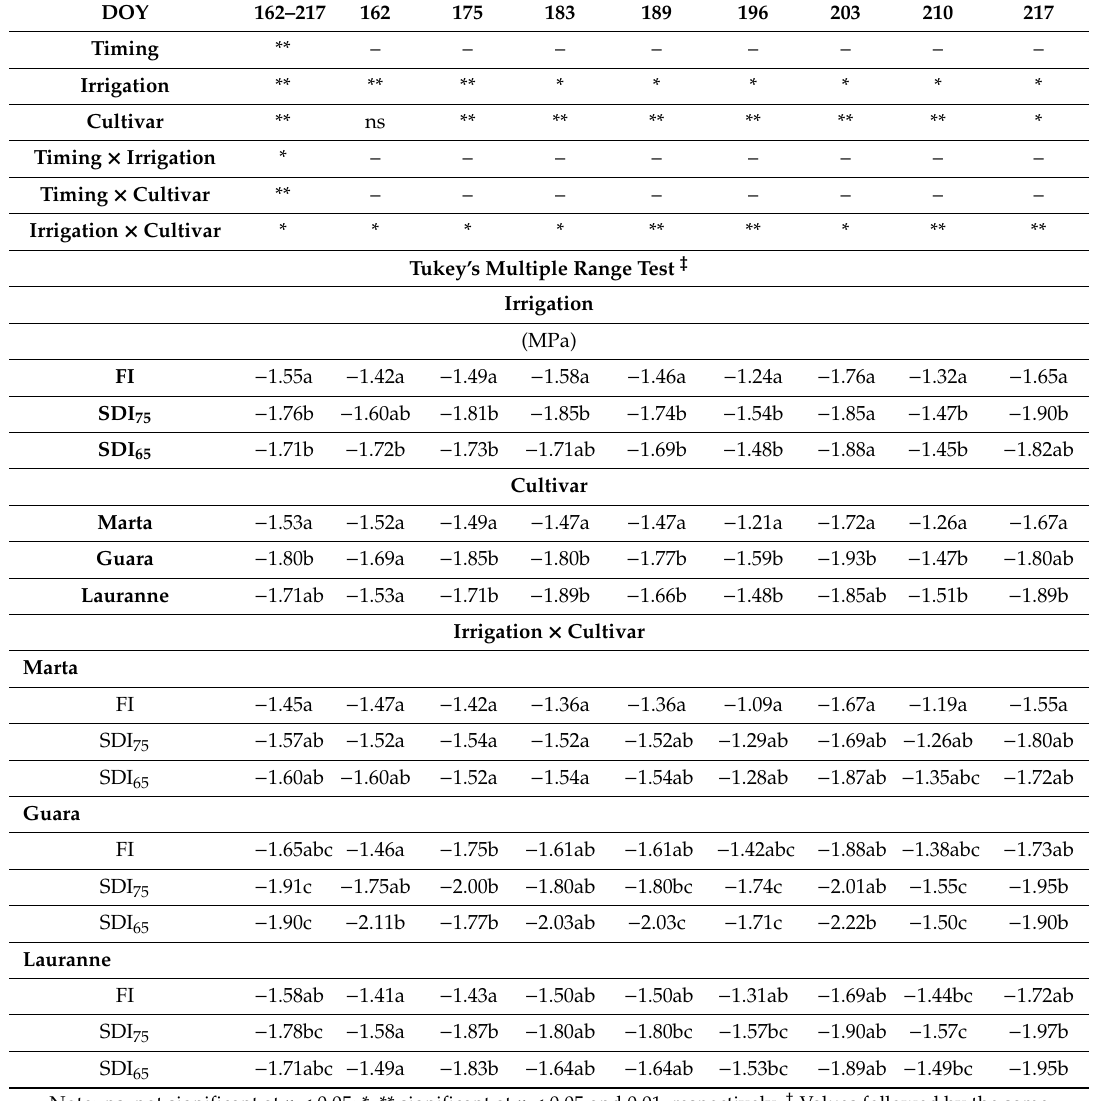
Table 1. Evolution of crop water status in terms of leaf water potential ( Ψ leaf